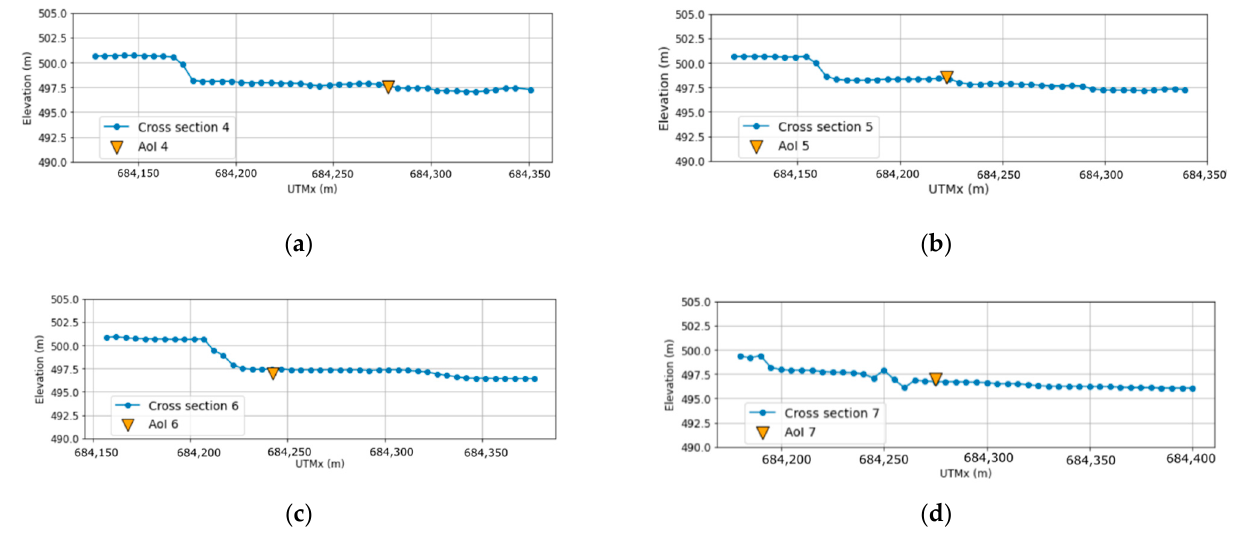
Figure 17. Zoom in areas with misclassified AoI and location of cross sections: ( a ) FP; ( b ) FN. Axes represent UTM coordinates.